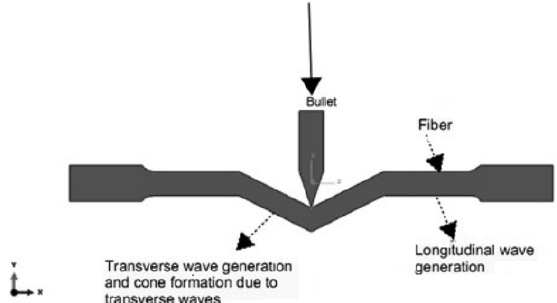
Figure 15. Propagation of longitudinal and transverse waves during impact event.